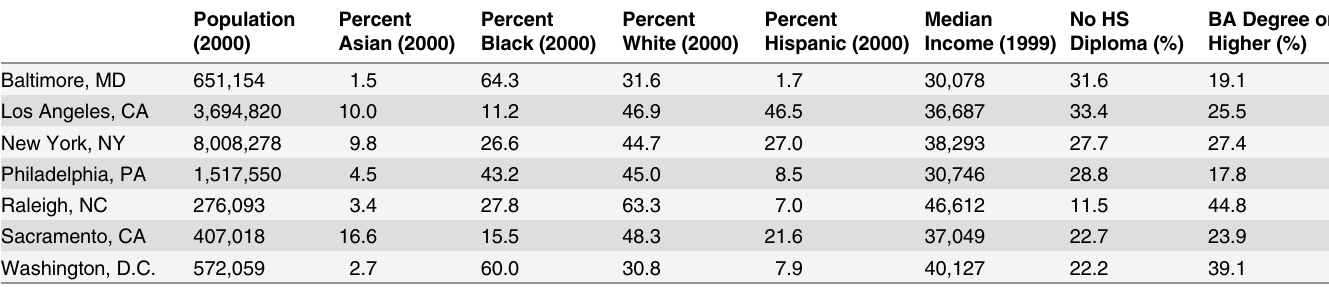
Table 1. Site Descriptions — Social variables for the seven study